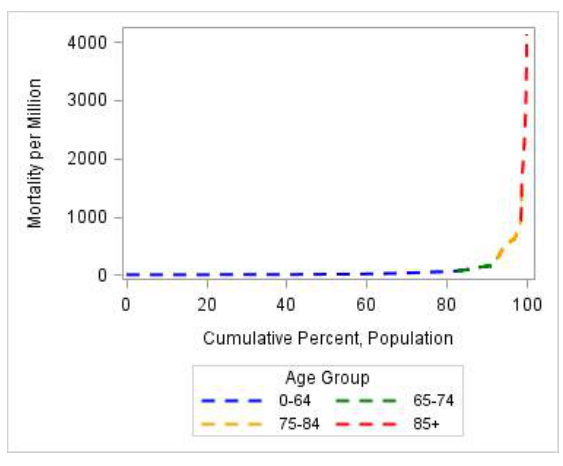
Figure 4. The heat-related mortality risk per million population for summer 2030, by cumulative population percent and age classification.